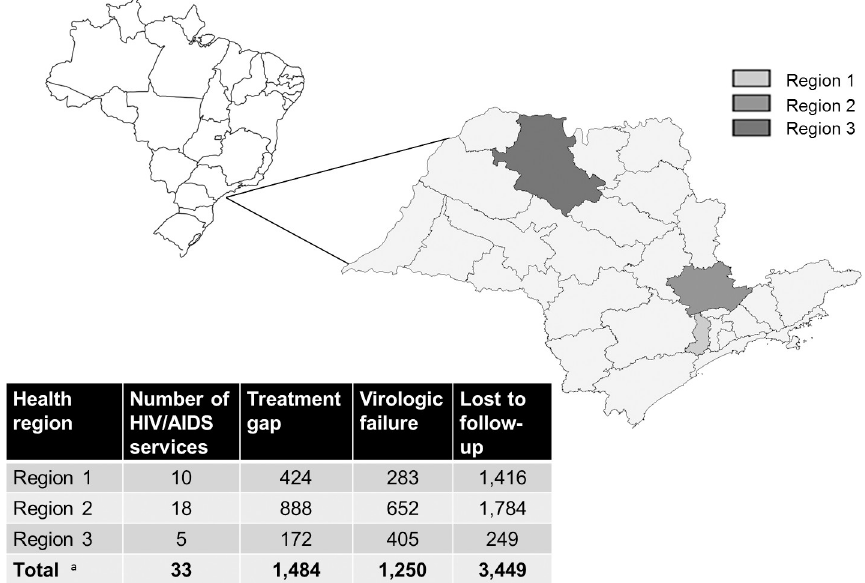
Fig 4. Health regions and services included in the intervention and number of patients with treatment gap, virologic failure, or who were lost to follow-up. a. Clinical Monitoring System, May 2019.